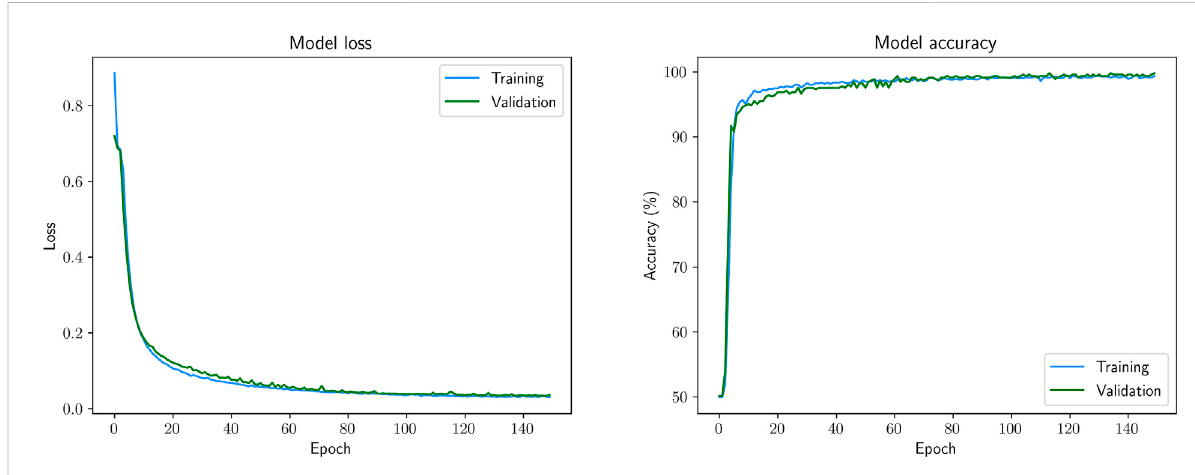
FIGURE 8 Model loss and accuracy on training and validation data for the fi nal structure network.